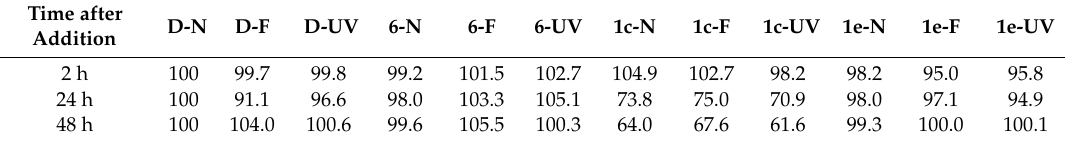
Table 7. MTT absorbances relative to 1% DMSO cell control, 6 , 1c , or 1e at 2, 24, and 48 h post addition.